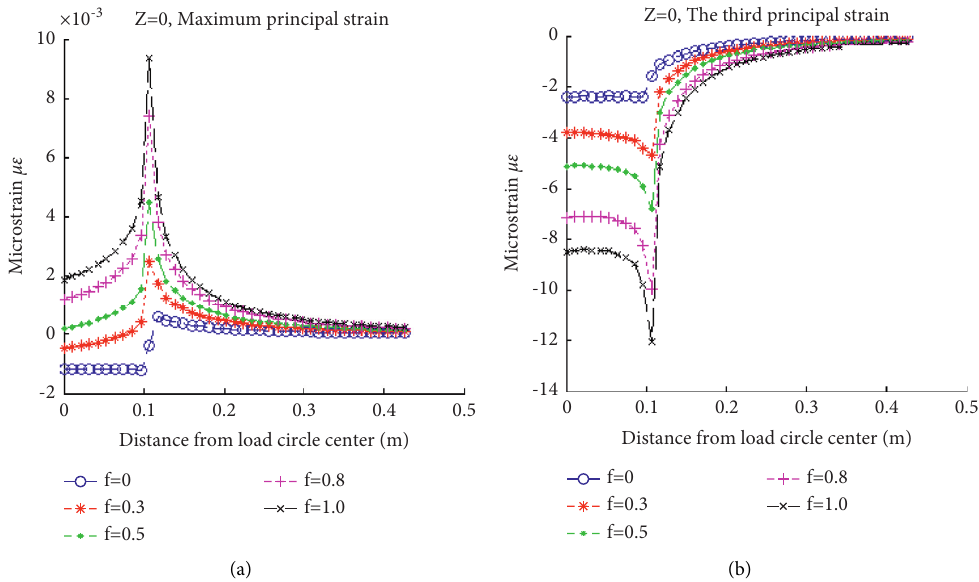
Figure 11: Calculation results of principal strain of structure in x -axis ( z � 0). (a) Calculation results of maximum principal strain of structure in x -axis ( z � 0). (b) Calculation results of third principal strain of structure in x -axis ( z �